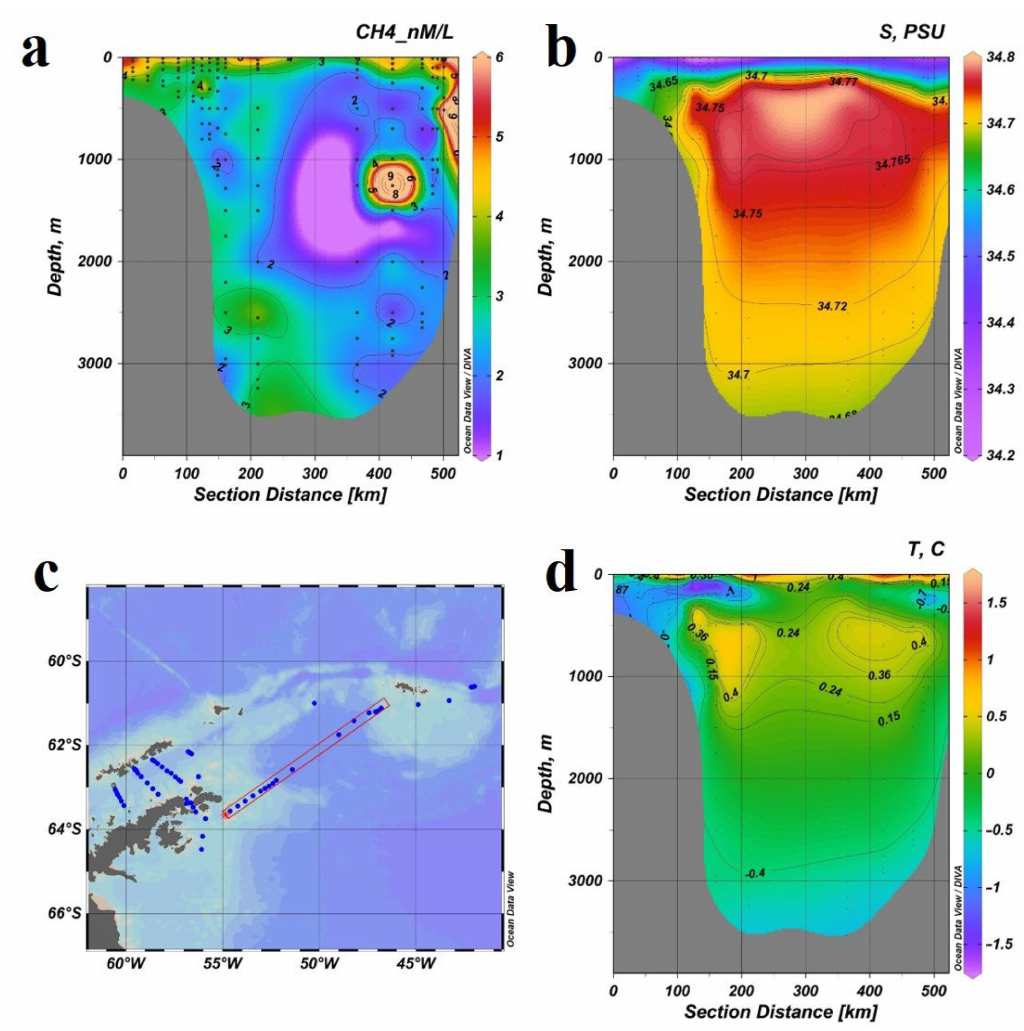
Figure 10. Distribution of methane concentration ( a ), temperature ( d ) and salinity ( b ) on the 500 km section ( c ) through the Weddell